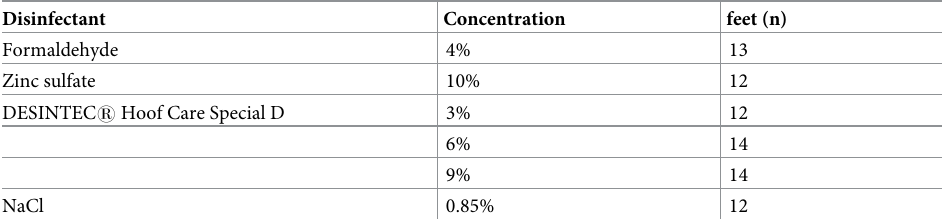
Table 2. Disinfectants and concentrations tested ex vivo for their effect on reduction of live D . nodosus